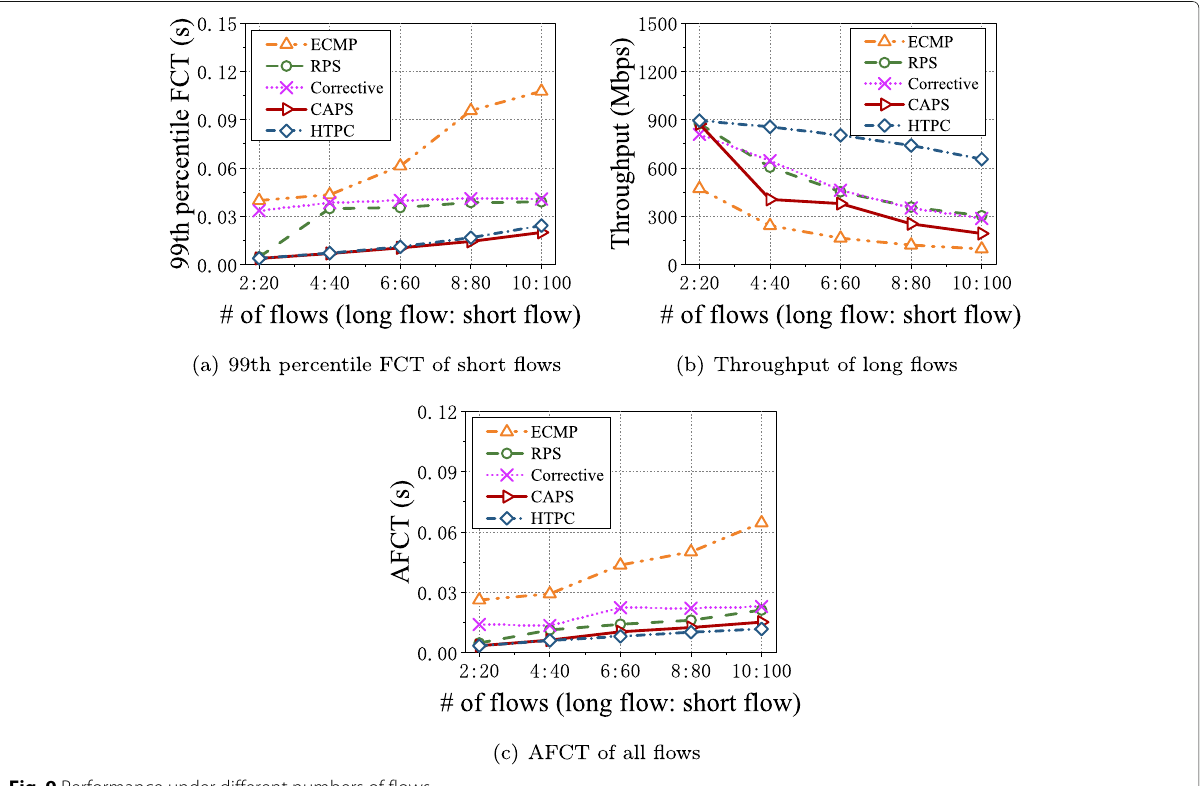
Fig. 9 Performance under different numbers of flows